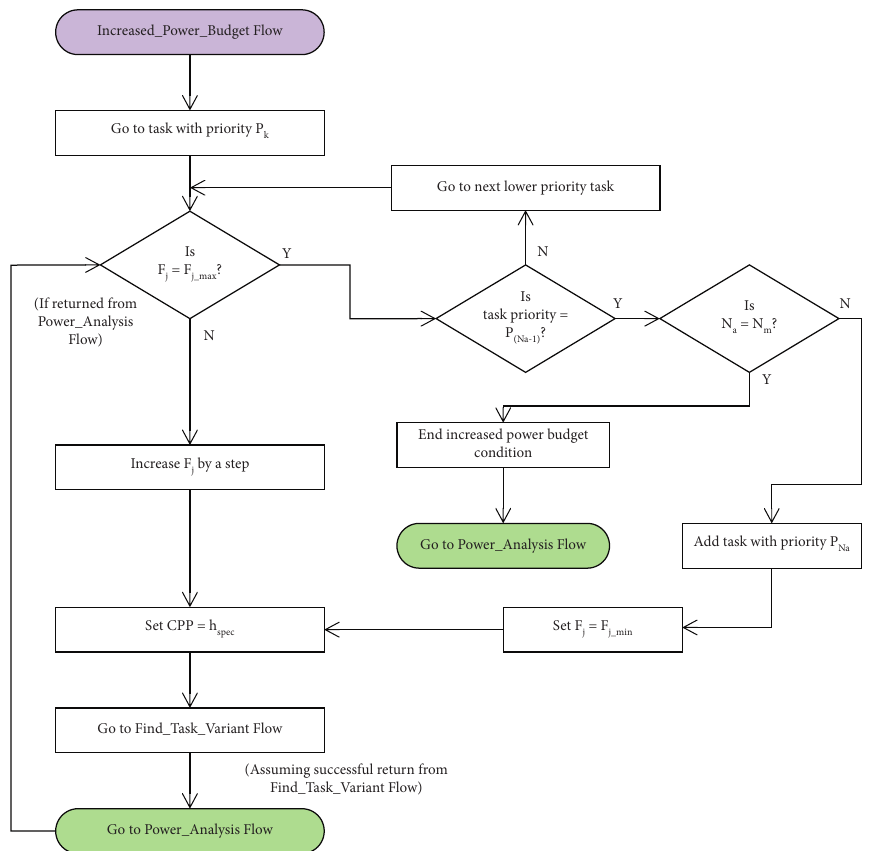
Figure 10: Increased_Power_Budget flow of